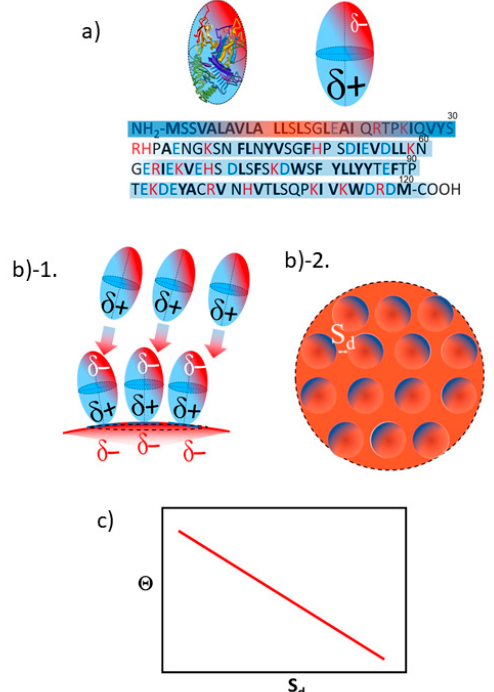
Figure 9. A sketch explaining negative linear relationship between Θ vs. S d . ( a ) simulation of prolate and charge distribution of β 2m. The sequences are shown with the colored bar indicating δ – (in red) or δ + (in blue). ( (b)-1 ). A side view of a prolate top peptide with δ + side of dipole attaching to δ – surface of gold colloid. Because a distribution of δ – is expected to be spread from the top to the side toward outside, extra prolate is more attracted as more area of δ – is available. ( (b)-2 ). A top view of a focused region in b)-1, where the area appears as δ – as the prolate locate close by shortening of S d . ( c ). A graph explaining the expected trend between Θ as a function of S d, .